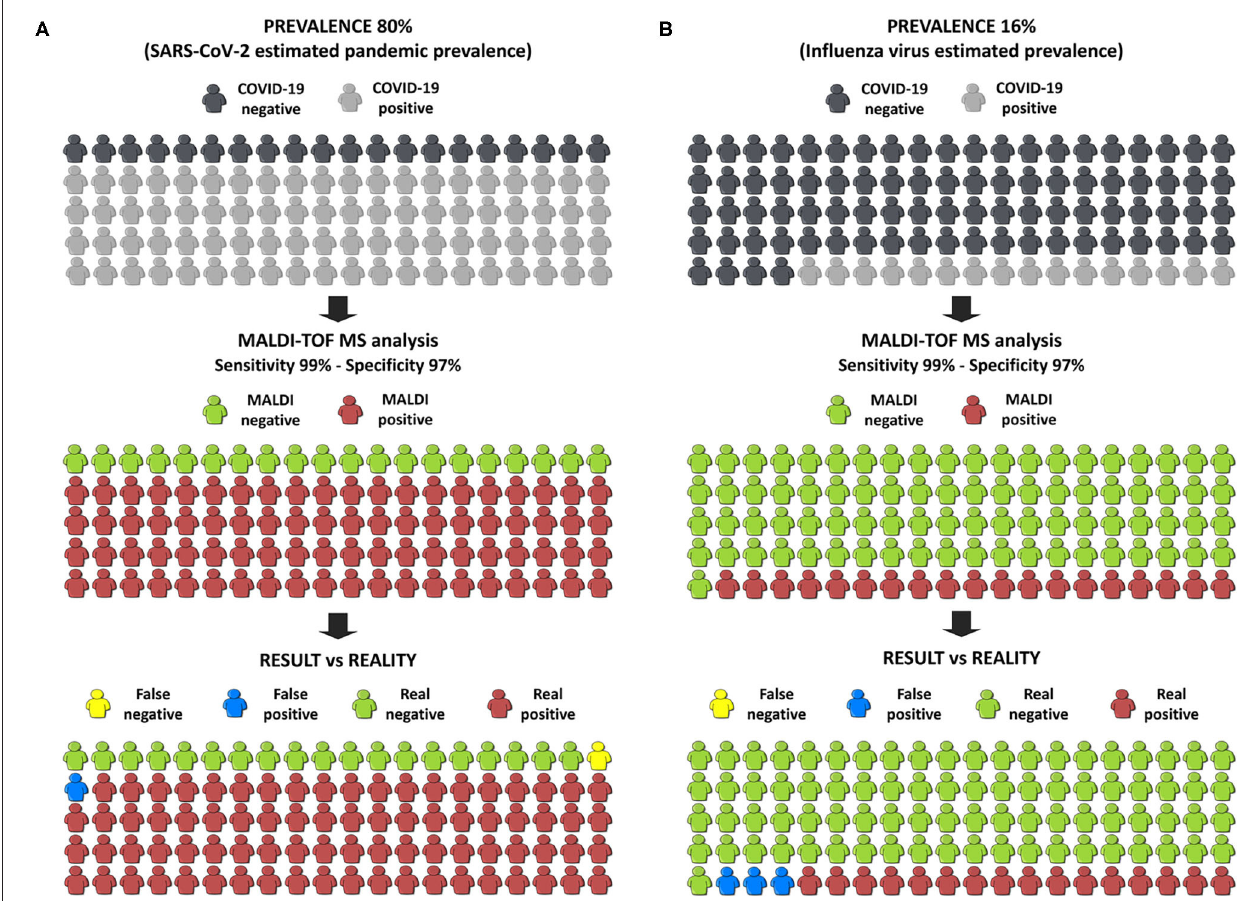
FIGURE 6 | Infographic of the simulation of the results in the society. (A) Simulation in a pandemic situation. (B) Simulation in a post-pandemic